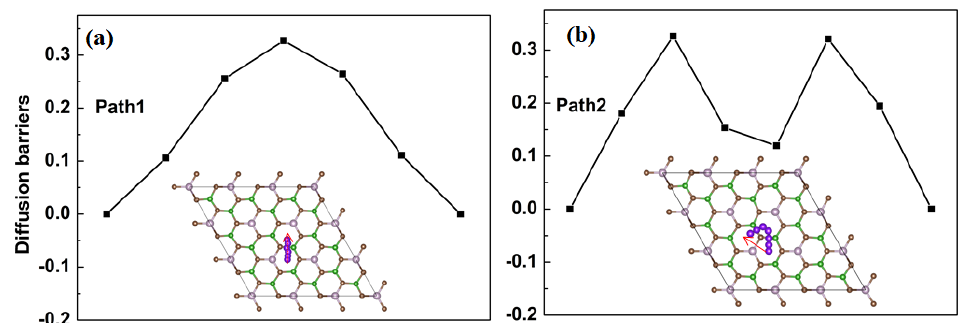
Figure 3. Diffusion barriers of Li-ion on the surface of B 2 C 3 P along ( a ) path 1, and ( b ) path 2. The insets are the corresponding trajectories of Li-ion diffusion over the surface of B 2 C 3 P, while the red arrows indicate the settled artificially-initial paths.